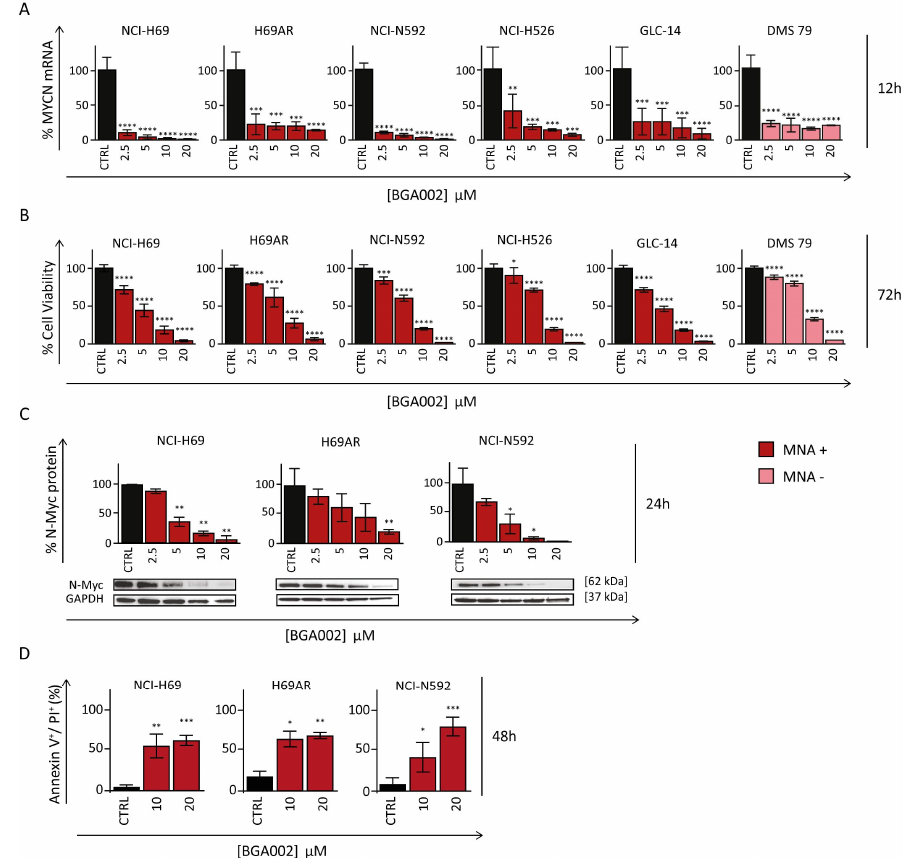
Figure 1. BGA002 reduces MYCN expression leading to cell growth inhibition and apoptosis activa- tion in SCLC cell lines. ( A ) MYCN mRNA expression inhibition through RT-PCR after 12 h of treatment in SCLC cell lines. Bars, mean; whiskers, SD (n = 3, biological replicates for each cell line). ( B ) Cell viability assay showing a decrease after 72 h of treatment. Bars, mean; whiskers, SD (n = 3, biological replicates for each cell line). ( C ) Representative Western blot analysis after 24 h of treat- ment. Representative staining for N-Myc (top) and associated GAPDH staining (bottom) is shown. Top, quantification of N-Myc expression (normalized with GAPDH signal). Bars, mean; whiskers, SD (n = 3, biological replicates for each cell line). The original western blots are shown in File S1. ( D ) Apoptosis measured after 48 h of treatment for NCI-N592 (right), H69AR (middle) and NCI-H69 (left) cell lines. Bar plots represent the percentage of cells stained by Annexin V+/PI+. The bars rep- resent the mean, and the whiskers are the standard deviation (n = 3 experiments for each cell line). Data are analyzed with a two-tailed Student’s t -test: *, p ≤ 0.05; **, p ≤ 0.01; ***, p ≤ 0.001; ****, p ≤ 0.0001; where not indicated, p -value > 0.05.